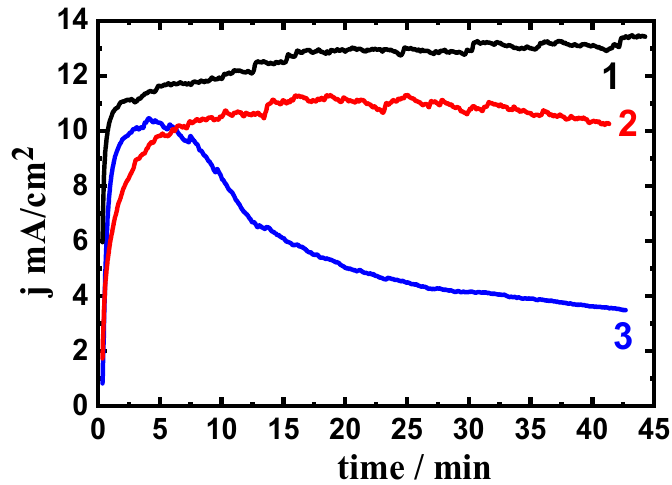
Figure 10. PCT curves obtained at − 500 mV for (1) first Al-SiC nanocomposite, (2) second Al-SiC nanocomposite and (3) third Al-SiC nanocomposite after their immersion in 3.5% NaCl solutions for 1 h.